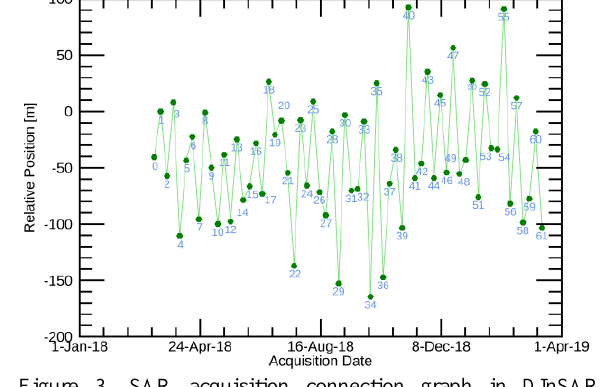
Figure 3. SAR acquisition connection graph in DInSAR processing